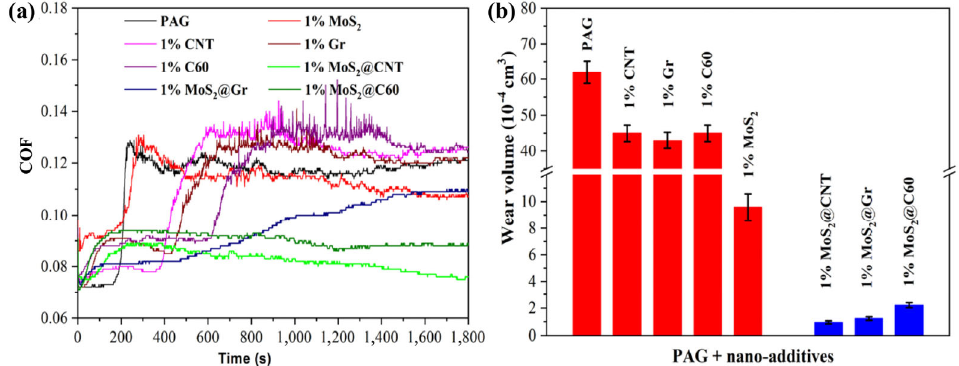
Fig. 5 (a) COF and (b) wear volumes of steel discs lubricated by PAG base oil and PAG additized with 1 wt% CNT, 1 wt% Gr, 1 wt% C60, 1 wt% MoS 2 , 1 wt% MoS 2 @CNT, 1 wt% MoS 2 @Gr, and 1 wt% MoS 2 @C60 at 100 °C (SRV conditions: load, 100 N; stroke, 1 mm; frequency, 25 Hz; duration, 30